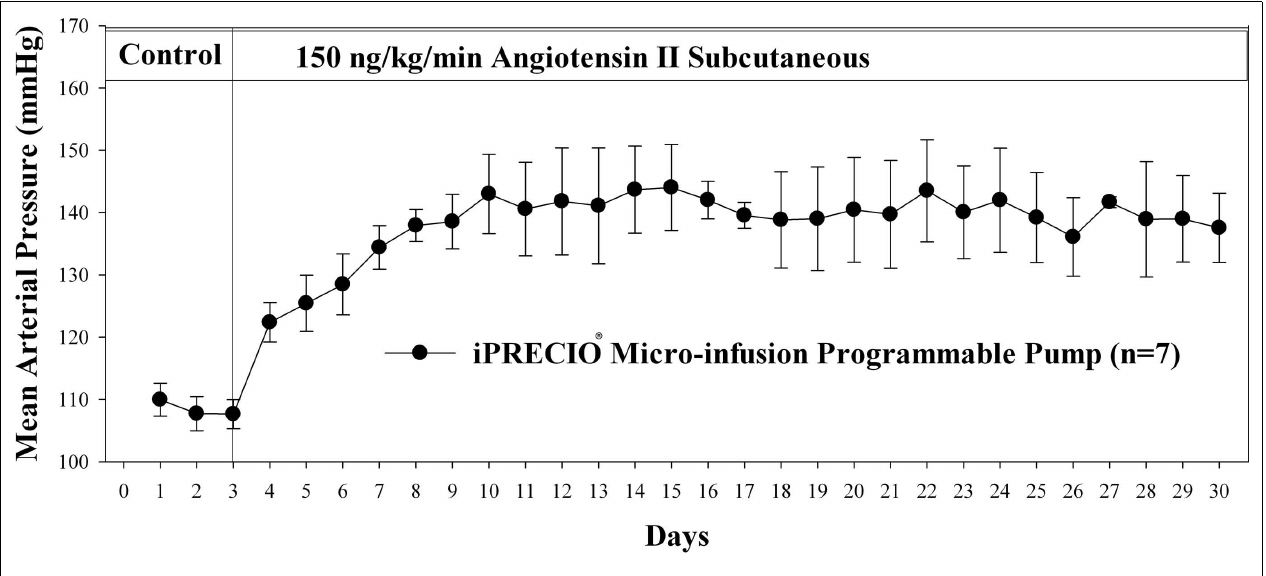
FIGURE 5 | While the Alzet ® pump ( Figure 4 ) could only be used for 14days, the iPRECIO ® pump (same infusion flow-rate as Alzet ® ), after transcutaneous refills, maintained an elevated level of arterial pressure.There are longer duration Alzet ® pumps but they operate with a lower infusion rate. iPRECIO ® pumps will infuse for up to 6months at 1 μ l/h.The longest duration Alzet ® pump would only infuse for